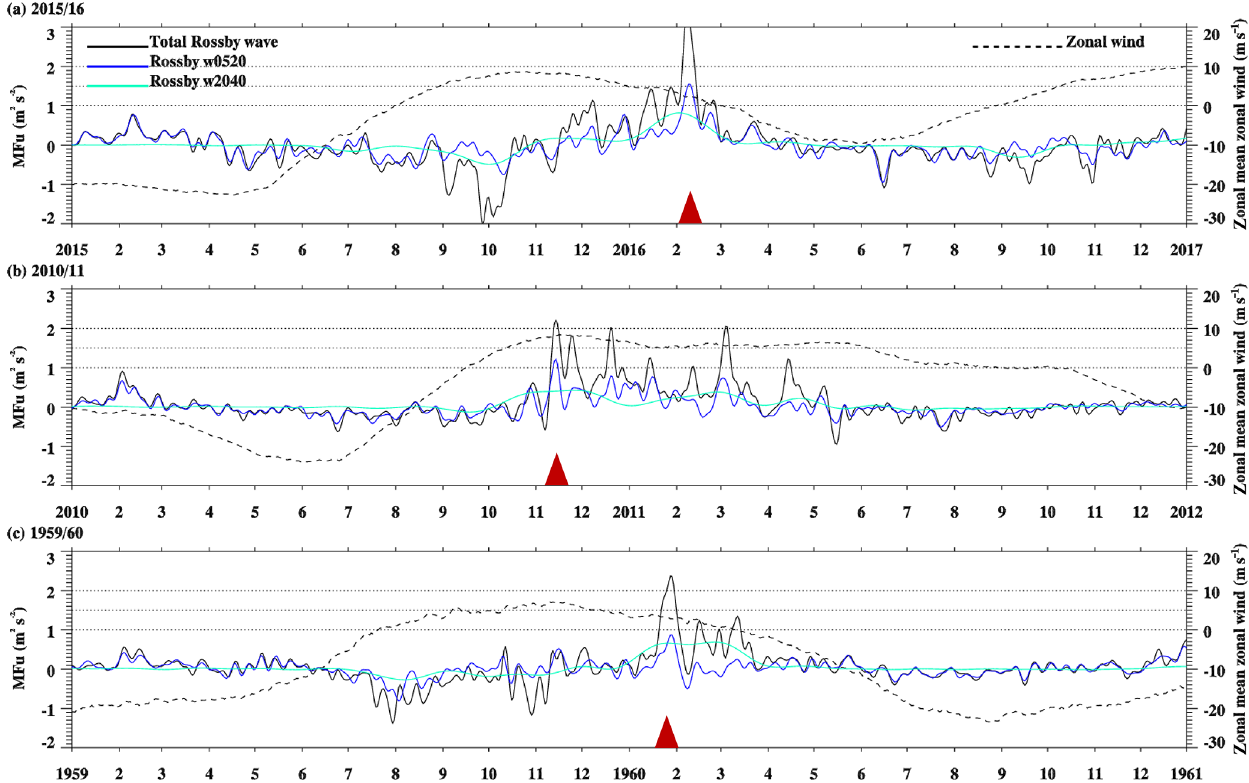
Figure 5. Temporal evolution of horizontal Rossby wave momentum flux anomalies over the tropics (10 ◦ S–10 ◦ N) during (a) 2015/2016, (b) 2010/2011, and (c) 1959/1960 at 40hPa. The horizontal dotted lines denote the values of horizontal momentum flux anomaly of Rossby waves of 1, 1.5, and 2m 2 s − 2 . The black, dark blue, and light blue solid lines denote the horizontal momentum flux anomaly of total Rossby wave (corresponding to Rossby w0570), Rossby w0520, and Rossby w2040, respectively. The dashed lines denote the background zonal wind during each case. Red triangles in panels (a) , (b) , and (c) denote February 2016, November 2010, and January 1960,